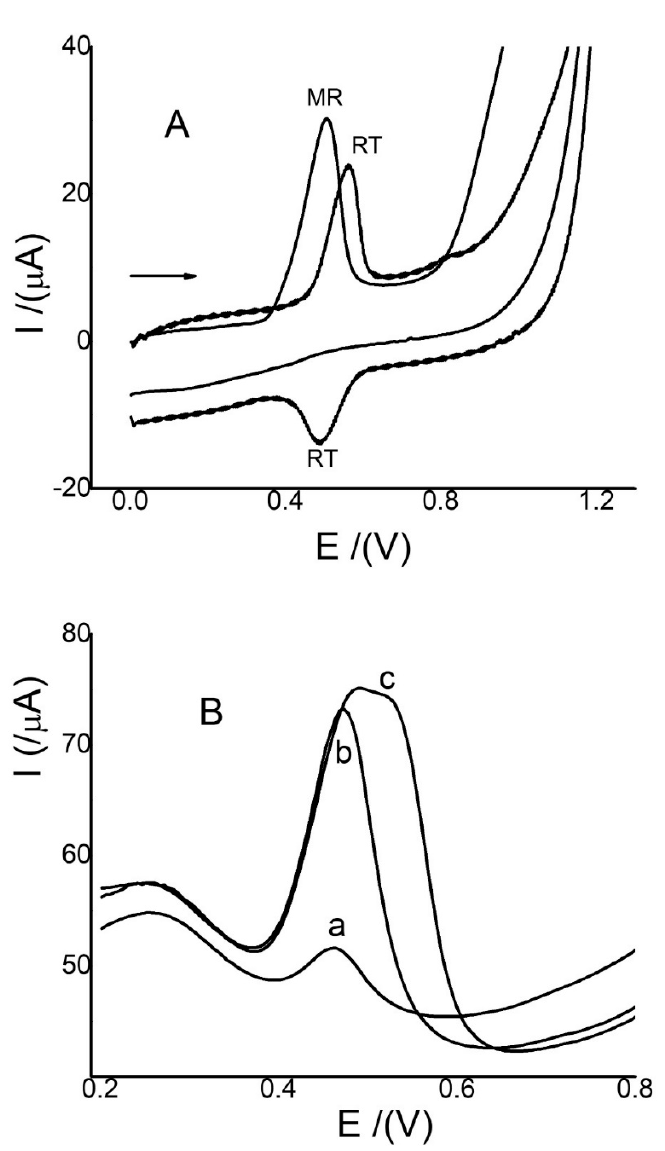
Figure 6. ( A ) CVs of MR (0.12 mmol/L) and RT (0.24 mmol/L), with Ch-G/GCE using 0.1 V/s and phosphate-buffered solution with a pH of 3.0; and ( B ) SWVs of coffee sample (curve a), MR 20.0 µmol/L (curve b), and RT 40.0 µmol/L with Ch-G/GCE. (curve c) Conditions: pH 3.0 (PBS) at 0.0 V for 30 s, 15 Hz, and pulse amplitude 0.05 V.